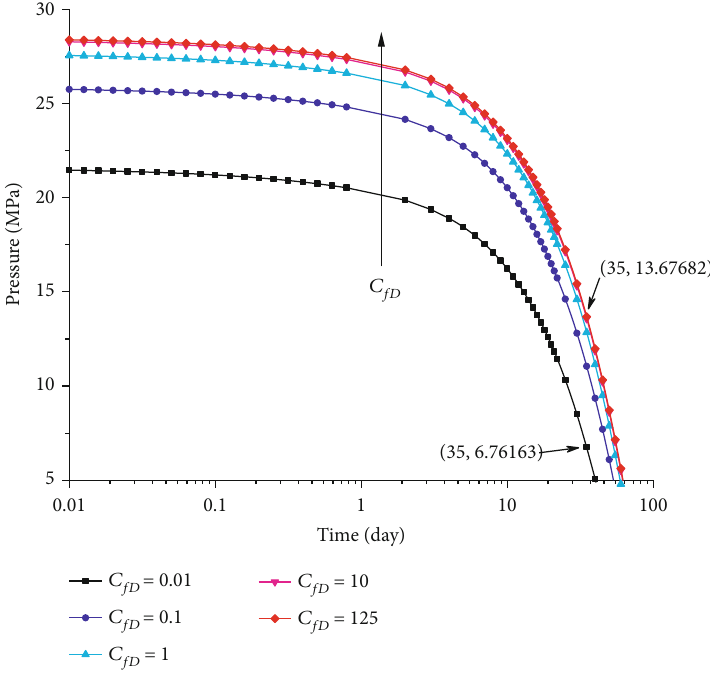
Figure 6: The e ff ect of fracture conductivity on the wellbore pressure (constant rate).